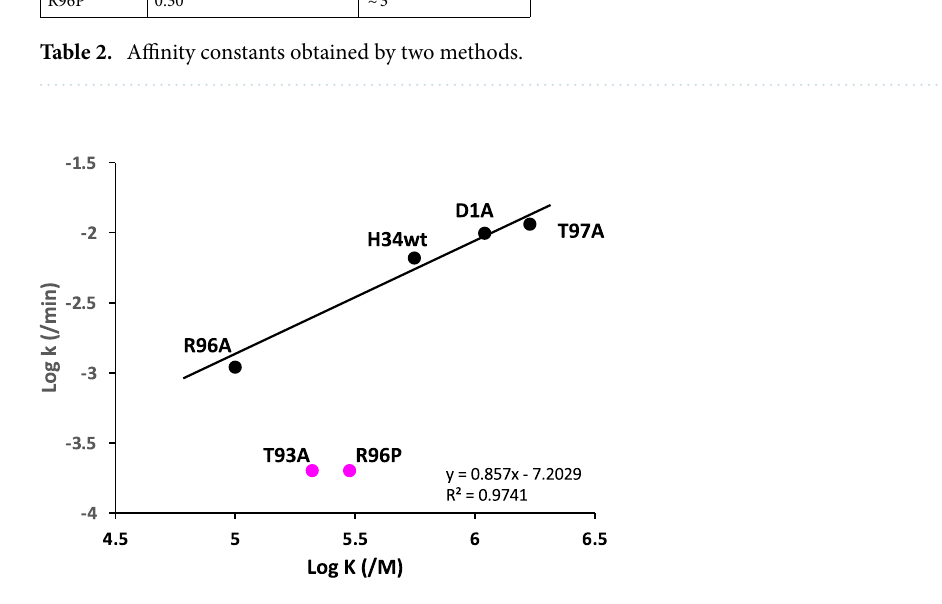
Figure 9. Linear Free Energy Relationship (LFER). LFER exists among the H34wt, T97A, D1A, and T93A clones, suggesting that features of these four clones are slightly different. In contrast, T93A and R96P are out of the linearity, indicating that the features of these two light chains must be hugely different from the above four